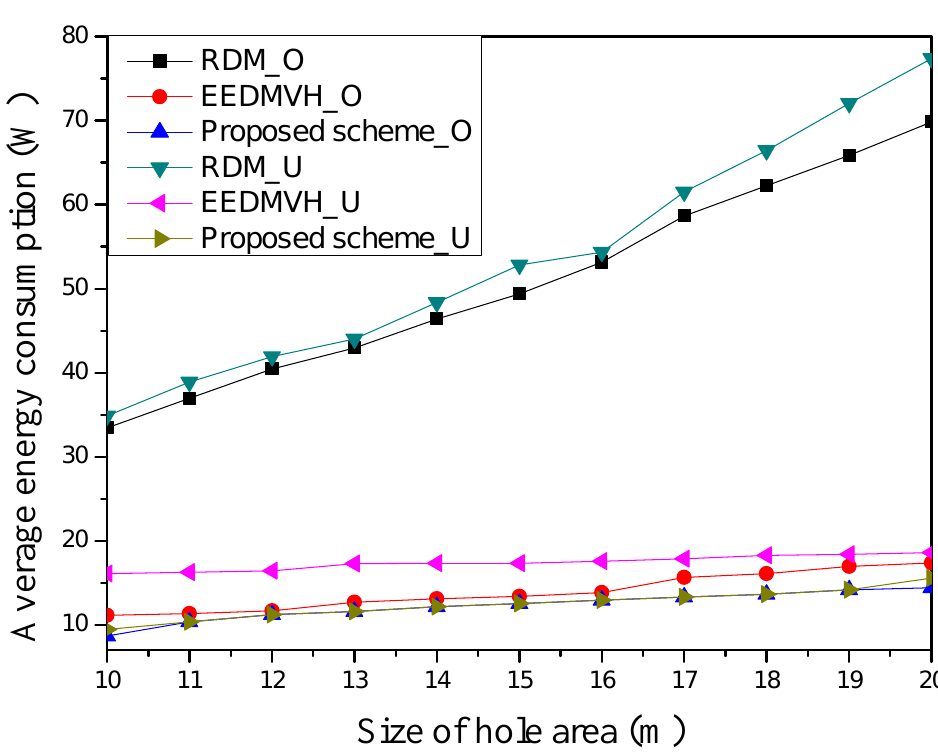
Figure 8. Average energy consumption according to hole size. By maintaining the hole-modeling area, RDM can detour the hole area safely, but that increases the additional average energy consumption due to hole modeling. As shown in Figure 9, as the distance shortens, the number of packet transmissions from the source node to the destination node decreases, and the energy consumption gradually decreases. On the other hand, EEDMVH can reduce the average energy consumption significantly when it compares with the research using hole modeling because it can detour the hole area without hole modeling. Unlike RDM, when this research faces the hole area, it can detour the hole area using face routing. Since there is no node required to model the hole area in this research, it can reduce the average energy consumption compared the previous simulation target. In addition, RDM can maintain the disjoint characteristic of multipath because it does not reuse marked nodes that it already uses as paths. As shown in Figure 9, even if the end-to-end distance is shortened, there is little effect on the amount of communication to detour the hole area. The proposed scheme has the lowest average energy consumption among the simulation targets because it identifies the hole area using face routing and then it avoids the identified hole area using greedy forwarding. This research is similar to the research using hole modeling, but it does not use the same hole-modeling process. Research using hole-modeling models larger than the shape of the hole area in order not to select the neighbor nodes near the hole area. However, when the proposed scheme encounters a hole area, it detours the hole area through face routing. After that, the proposed scheme identifies the detoured nodes near the hole area, and it generates a new path by avoiding the identified detour area. In addition, unlike EEDMVH, which uses face routing when it encounters a hole area, the proposed scheme uses greedy forwarding by avoiding the identified detour area when it generates a new multipath. Since the proposed scheme tries to mainly use greedy forwarding except for in the hole-detour process, there are similar results for the two hole models. Therefore, the proposed scheme can reduce the number of required nodes for data transmission around the hole area compared to the previous simulation target using face routing. As the distance decreases, the proposed scheme differs by about 20–30% from the simulation target using face